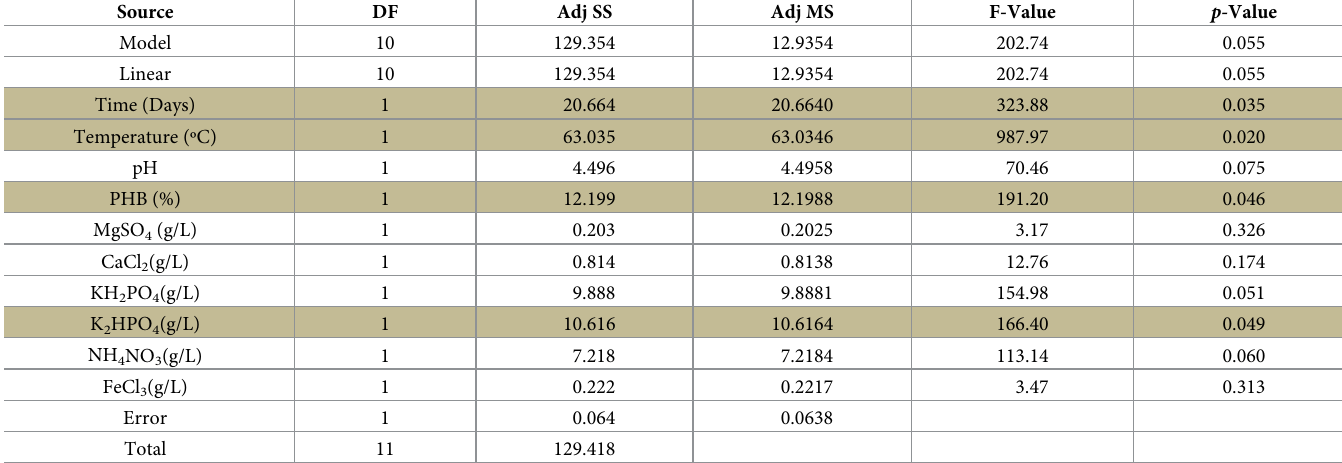
Table 8. ANOVA analysis for Plackett Burman design for PHB depolymerase enzyme production.